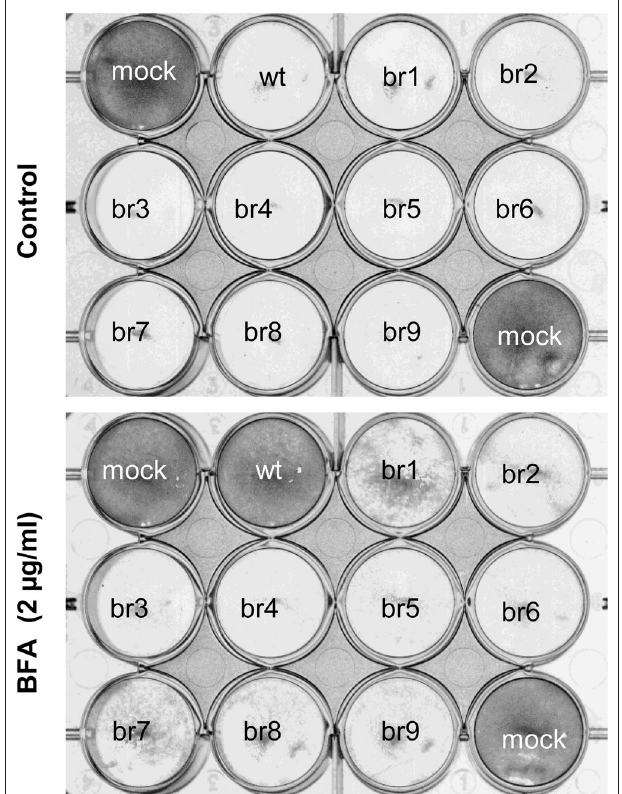
FIGURE 4 | Susceptibility of clones derived from SVDV B6 to BFA. IBRS-2 cells were infected with SVDV wt or the different drug resistant br1-9 clones at a moi of 0.1 pfu/cell and then incubated for 40 h in the absence or presence of 2 µ g/ml